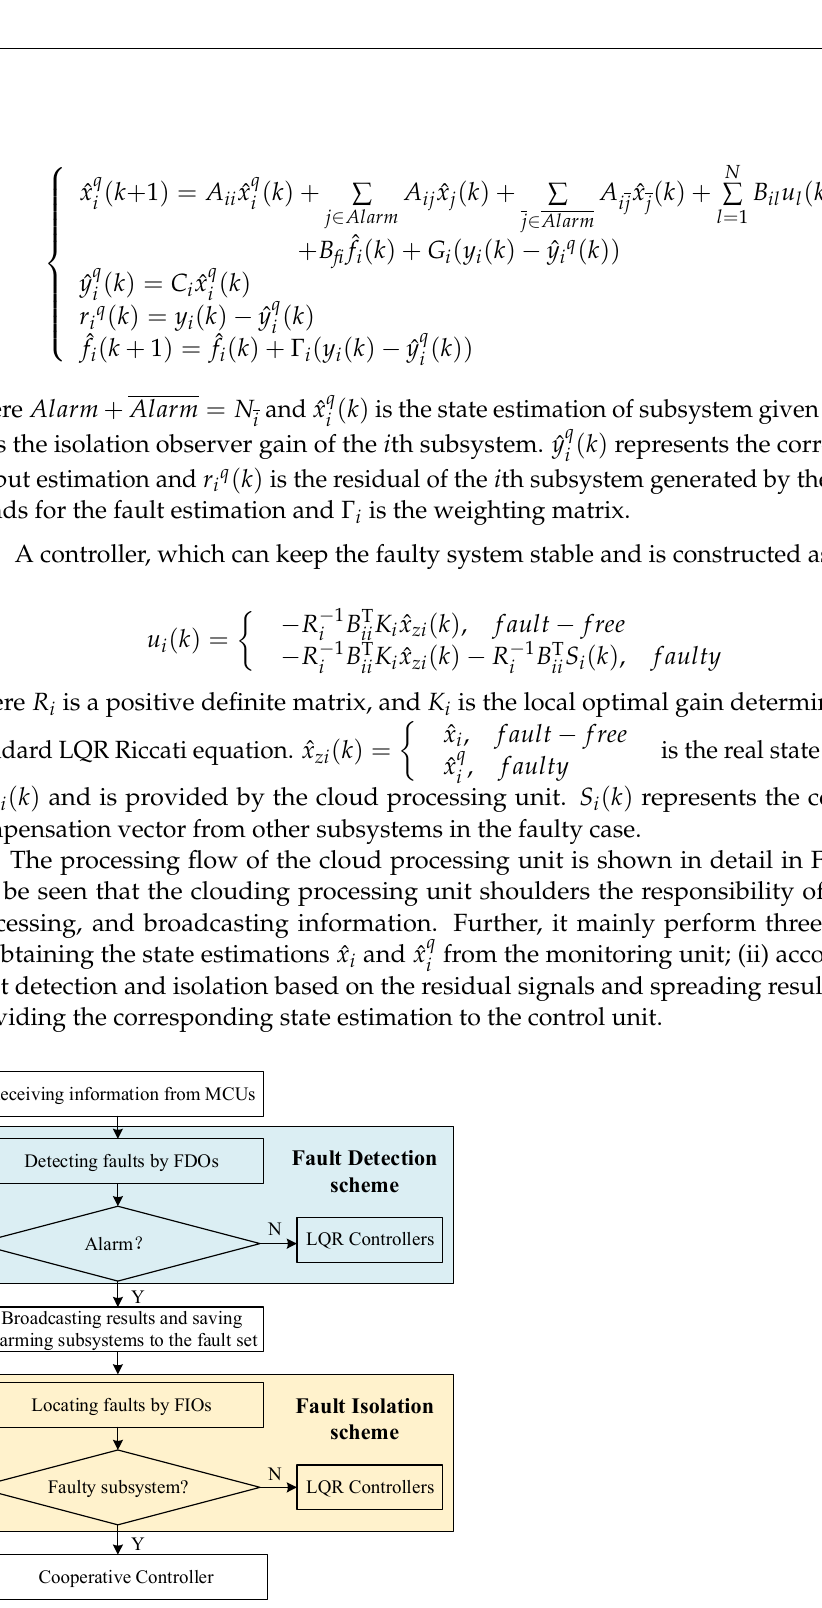
( b ) Figure 3. Fault detection and isolation schemes, where ( a ) represents fault detection scheme; ( b ) represents fault isolation scheme. In this paper, the design objective is to locate the fault accurately and achieve a co- operative fault-tolerant control. Hence, this paper studies the design of a novel fault di- agnosis framework, and the detection and isolation observer gain